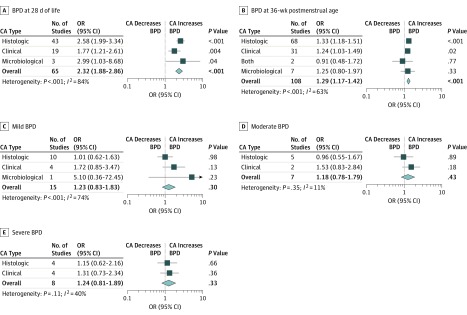
Meta-analyses of the Association Between Chorioamnionitis (CA) and Bronchopulmonary Dysplasia (BPD)Grouped by definition of CA. OR indicates odds ratio.